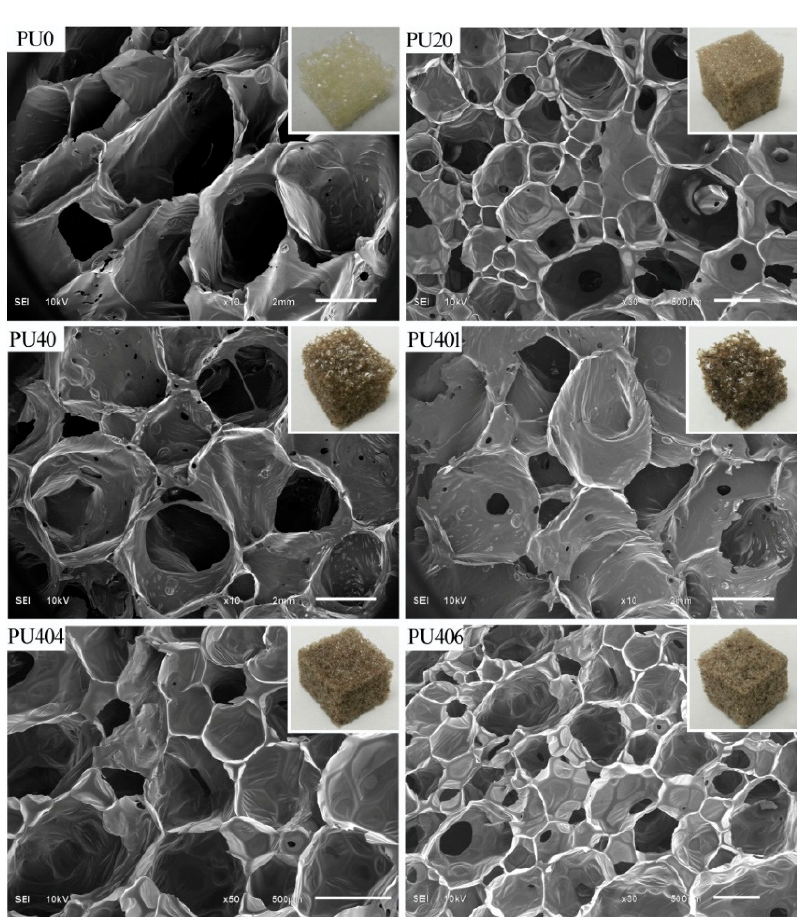
Figure 15. SEM images of bio-foams and cellulose nanocrystals reinforced bio-foams (Adapted from [99] ).